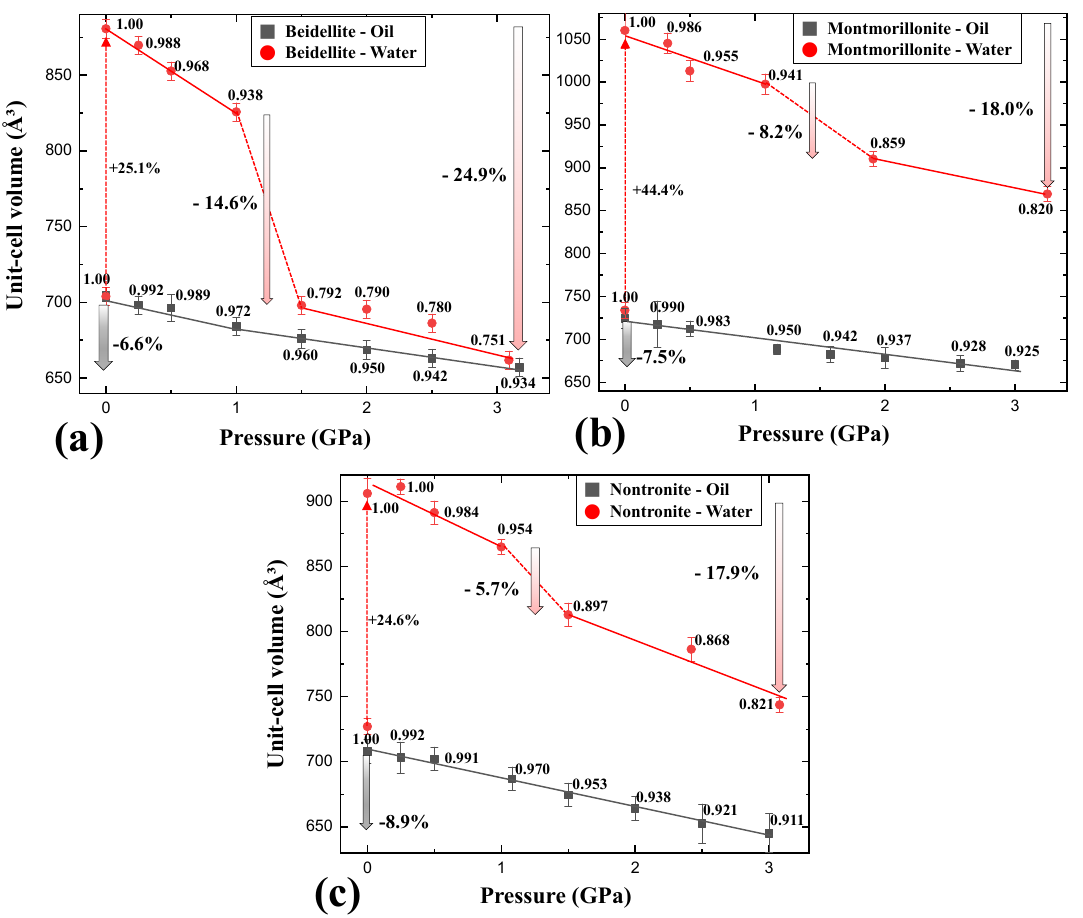
Figure 3. Pressure-dependent unit-cell volume changes of ( a ) beidellite, ( b ) montmorillonite, and ( c ) nontronite in silicone oil and distilled water PTMs for anhydrous and hydrous environments, respectively, at room temperature. Normalized volumes are shown on data points. The dashed and bold arrows show percent changes.